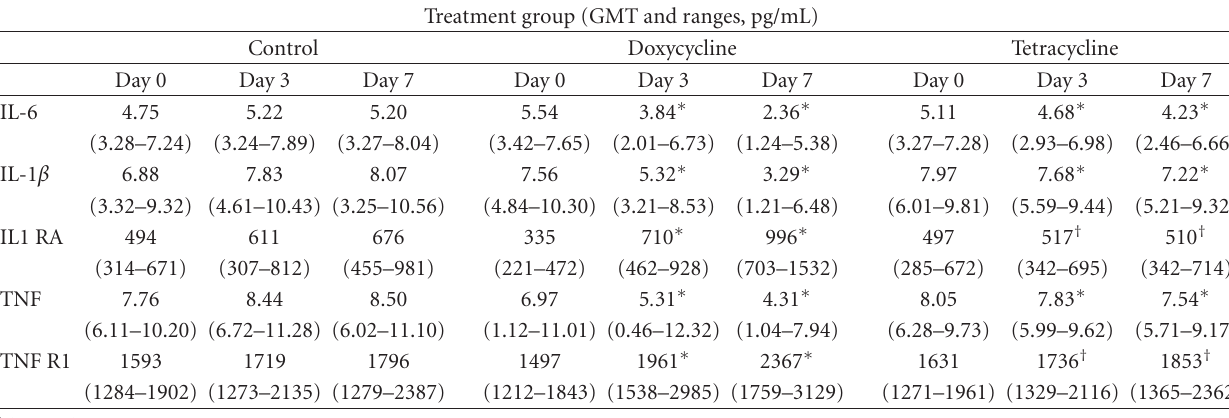
Table 2: E ff ect of Doxycycline and Tetracycline on cytokine levels and IL1-RA and S TNF-R1 in patients with dengue hemorrhagic fever. Treatment group (GMT and ranges,